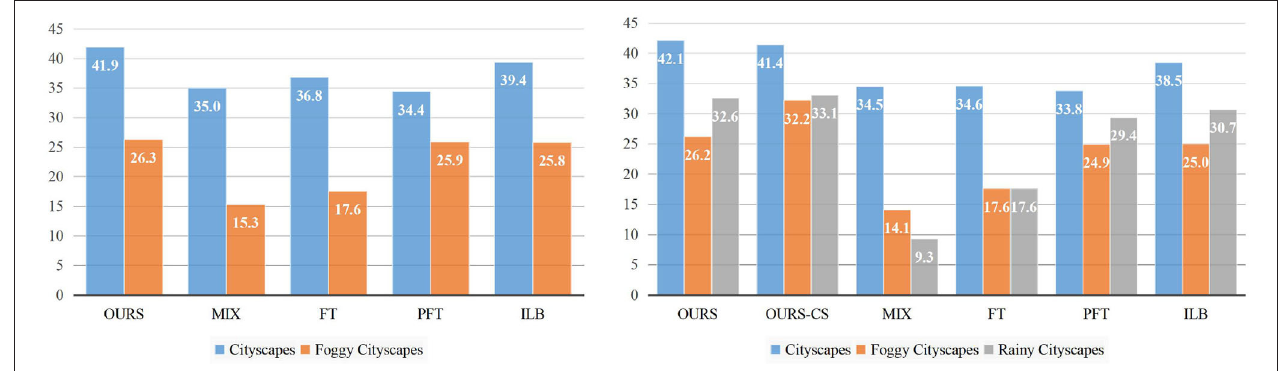
FIGURE 5 | Left: The adaptation results from Sim10K to Foggy-Cityscapes. Right: The adaptation result from Sim10K to Rainy-Cityscapes. The vertical and horizontal axis represents overall performance (mAP) and different datasets (domains).